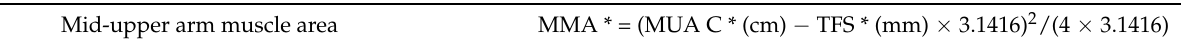
Table 4. Mid-upper arm muscle